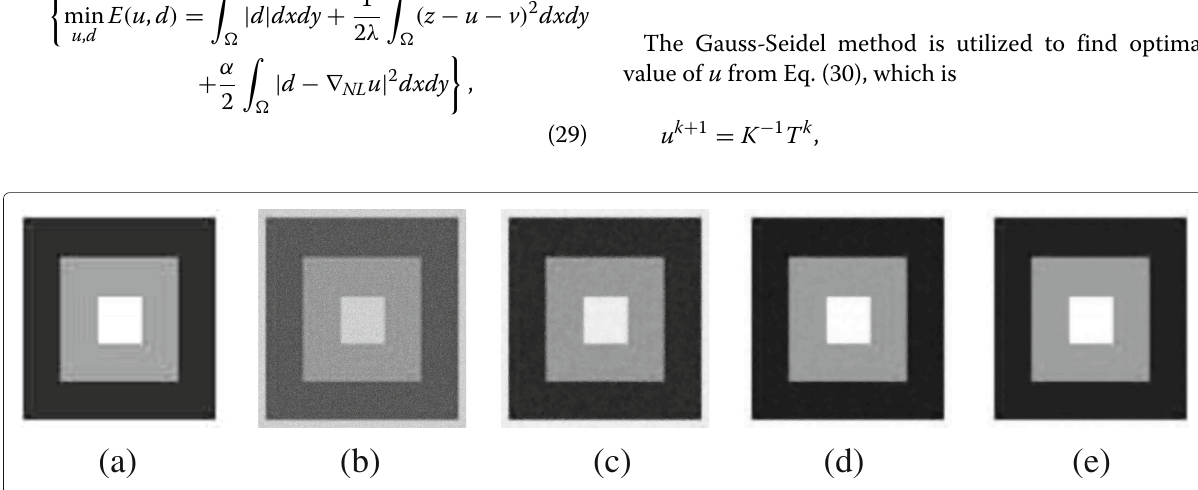
Fig. 4 Restored results on SynImage1; a original image; b SynImage1 image corrupted with additive Gaussian noise with σ = 18; c denoised image by method M1; d denoised image by method M2; e denoised image by method